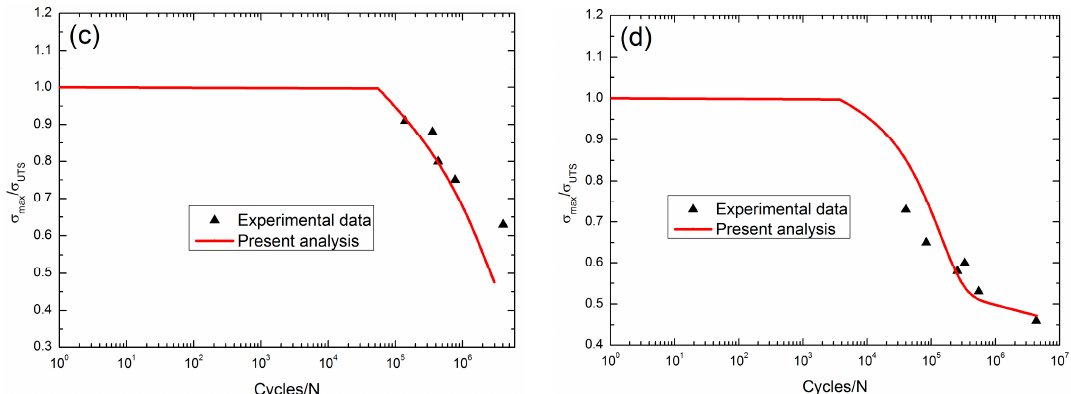
Figure 2. ( a ) The peak strain versus applied cycles with test environment of 0% moisture content condition and 60% moisture content condition; ( b ) the interface shear stress versus applied cycle with test environment of 0% moisture content condition and 60% moisture content condition; ( c ) the fatigue life S-N curve with test environment of 0% moisture content condition; and ( d ) with test environment of 60% moisture content condition of 2D SiC/SiC composite at 750 °C in air [2].